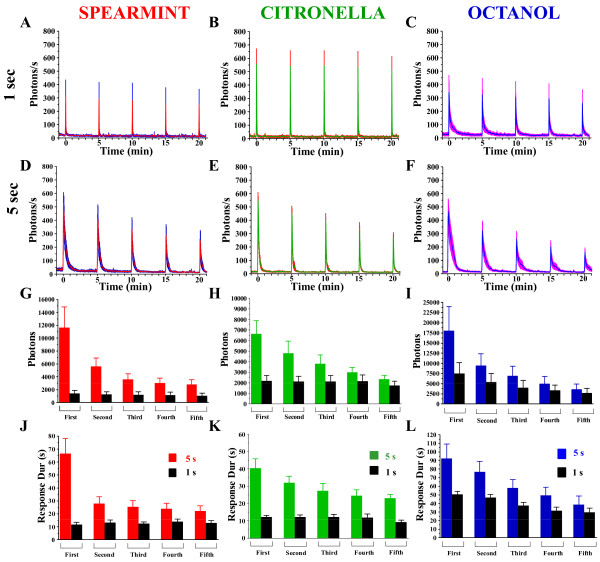
ORNs adapt to long-lasting and repeated odor stimulation. (A-F) Mean (+/- SEM) of amplitude of the response (photons/s) of different flies, versus time, of the Ca2+ -induced response (within the ROI) evoked by 1 s (A,B,C) or 5 s (D,E,F) application of spearmint (red-left column), citronella (green-middle column), or octanol (blue-right column) (Spearmint: red line = mean, blue = SEM) (Citronella: green line = mean, and red = SEM) (Octanol: blue line = mean, red = SEM) (same color-code for Figures 4 to 8). (G-I) Mean of the total number of photons of the 5 successive applications, for each odor. (J-L) Mean of the duration of the response (s). n = 5-9 flies for each condition. Values are means +/- SEM. Statistics: for the Amplitude (A-F): One-Way ANOVA, for the total photons and duration (G-L): Two-Way ANOVA (see Table 1 for complete statistical values). Remark that the ordinates (y-axis) of figures (G-I) and (J-L) have a different scale (also for other figures).